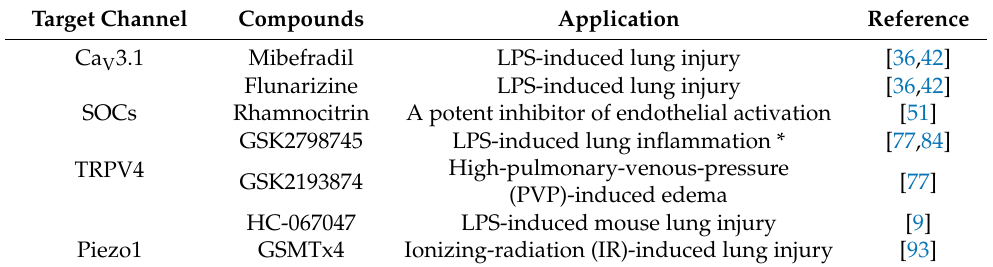
Table 1. Calcium-channel modulators with potential blockage of EC permeability during ALI. Target Channel Compounds Application Reference Ca V 3.1 Mibefradil LPS-induced lung injury [36,42] Flunarizine LPS-induced lung